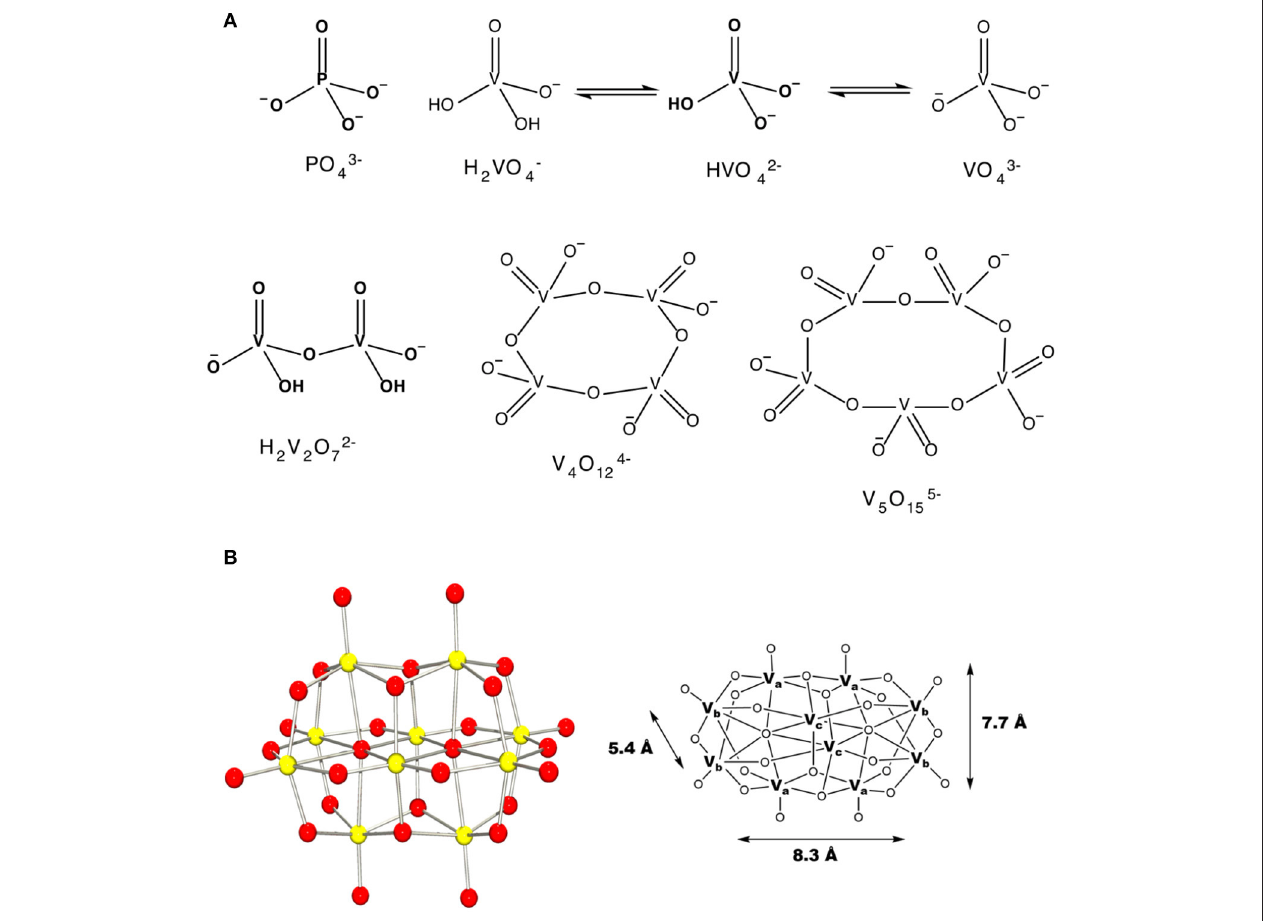
FIGURE 1 | The schematic structures of (A) monomeric vanadate, monomeric and polymeric vanadate series (B) X-ray structure of V 10 and the three different types of vanadium atoms in this complex ion with indicated dimensions (Evans, 1966). This figure was adapted with permission from Aureliano and Ohlin (2014), Crans et al. (2017)